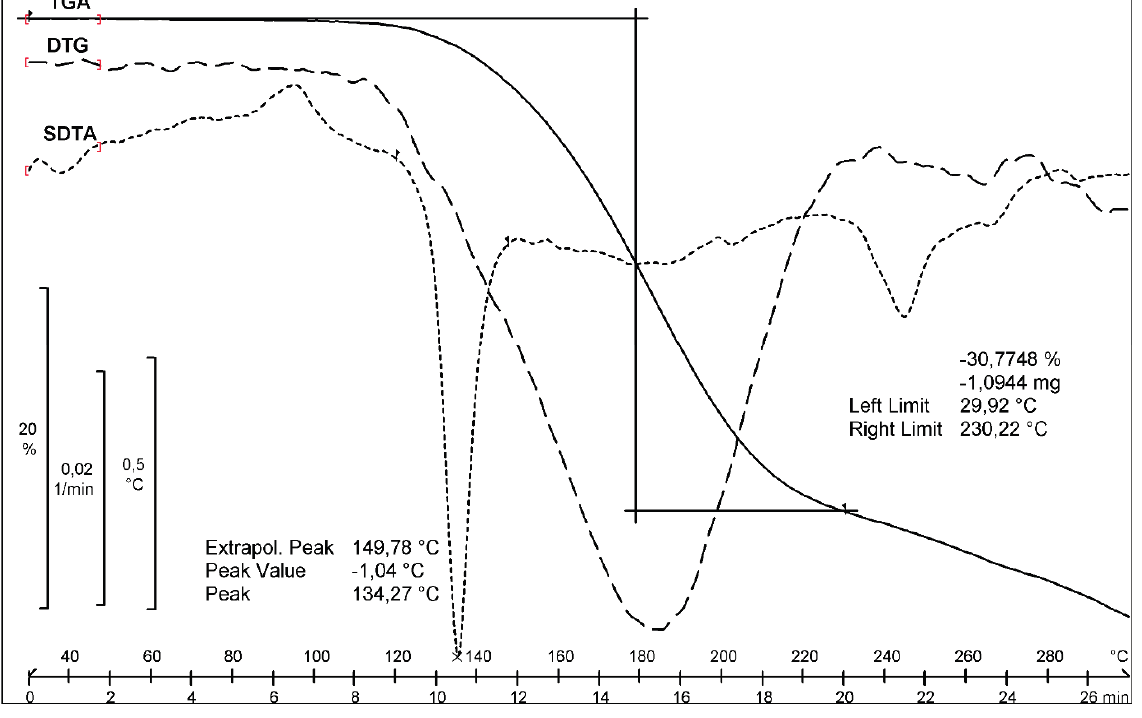
Figure 3. TGA, DTG and SDTA curves of pemetrexed diacid form 1